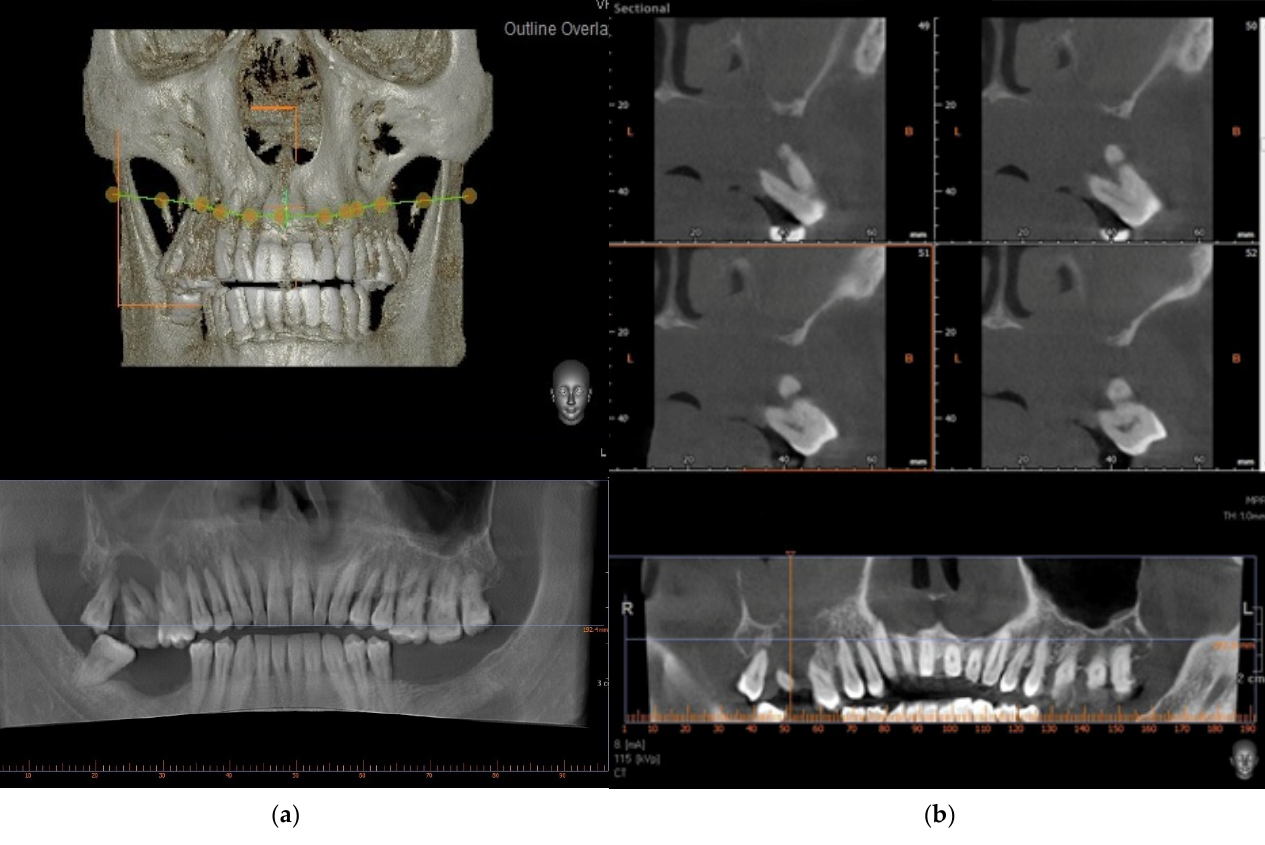
Figure 2. Preoperative radiograph images. In image ( a ) no bone destruction is detectable in the 3D reconstruction. Below, a simil panoramic image shows bone destruction in the upper right molar region ( a ). CBCT reveals the osteolytic change in the upper molar region, involving the hard palate (right) ( b ).